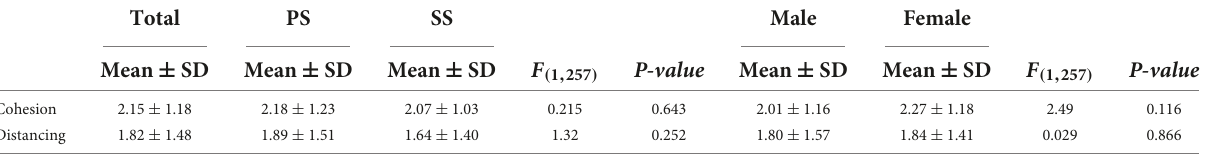
TABLE 4 Univariate analysis of variance of PAIR cohesion and distancing scales – based on school level and gender ( N = 257). Total PS